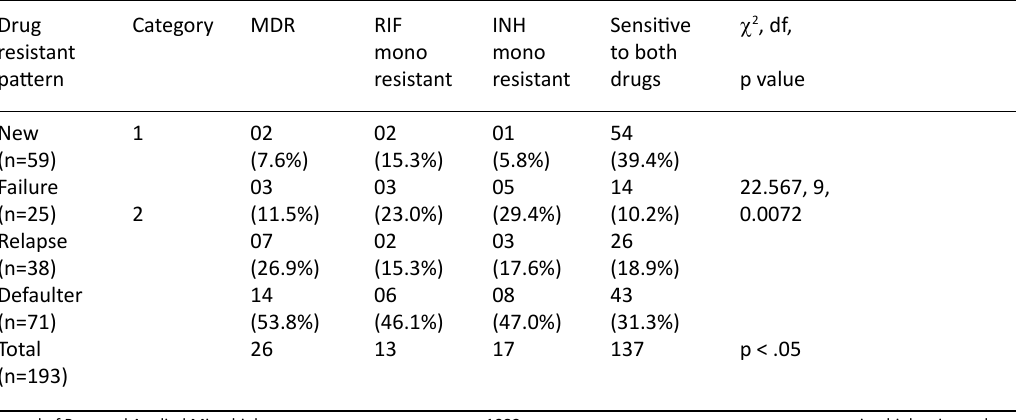
Table 5. Rifampicin and Isoniazid resistance pattern in relation to tuberculosis treatment history Drug